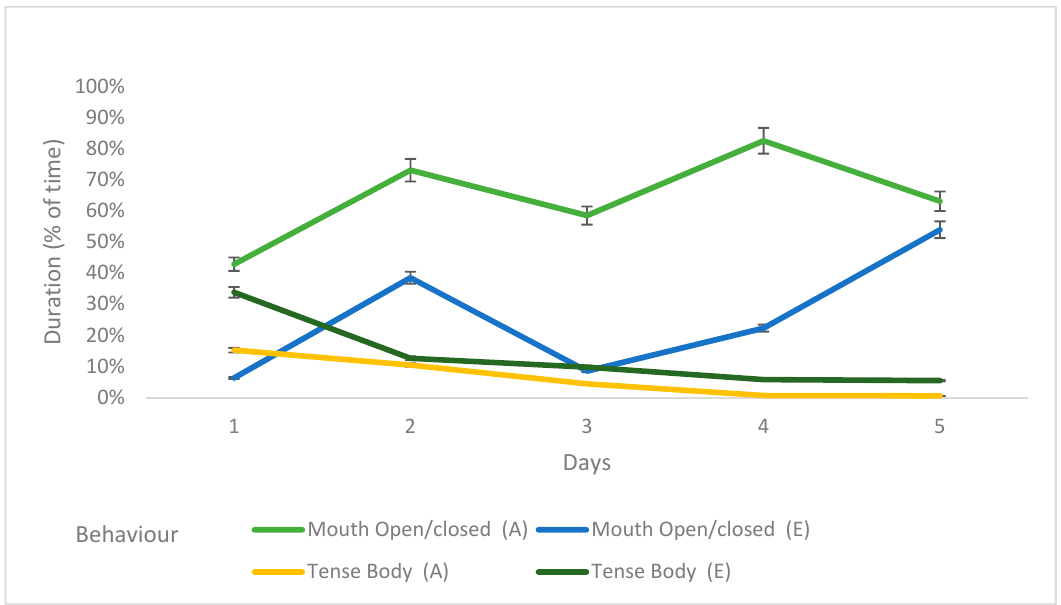
Figure 4. The duration of behaviours over the first five days that adopted or euthanased dogs ( n = 38)